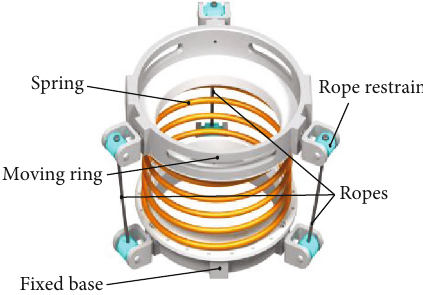
Figure 4: Structure of the fl exible parallel mechanism.